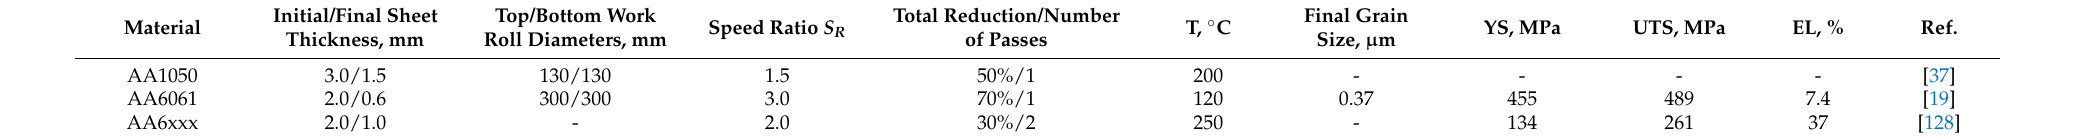
Table 6. Experimental data related to asymmetric warm rolling of Al